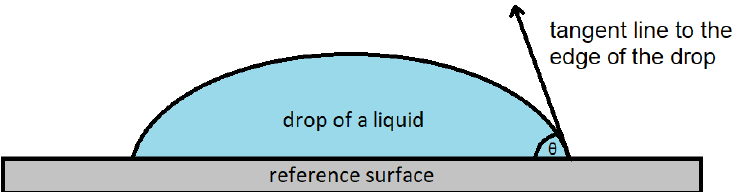
Figure 4. Graphical representation of contact angle determination using the sessile drop technique ( θ —the contact angle). Own drawing based on [16].